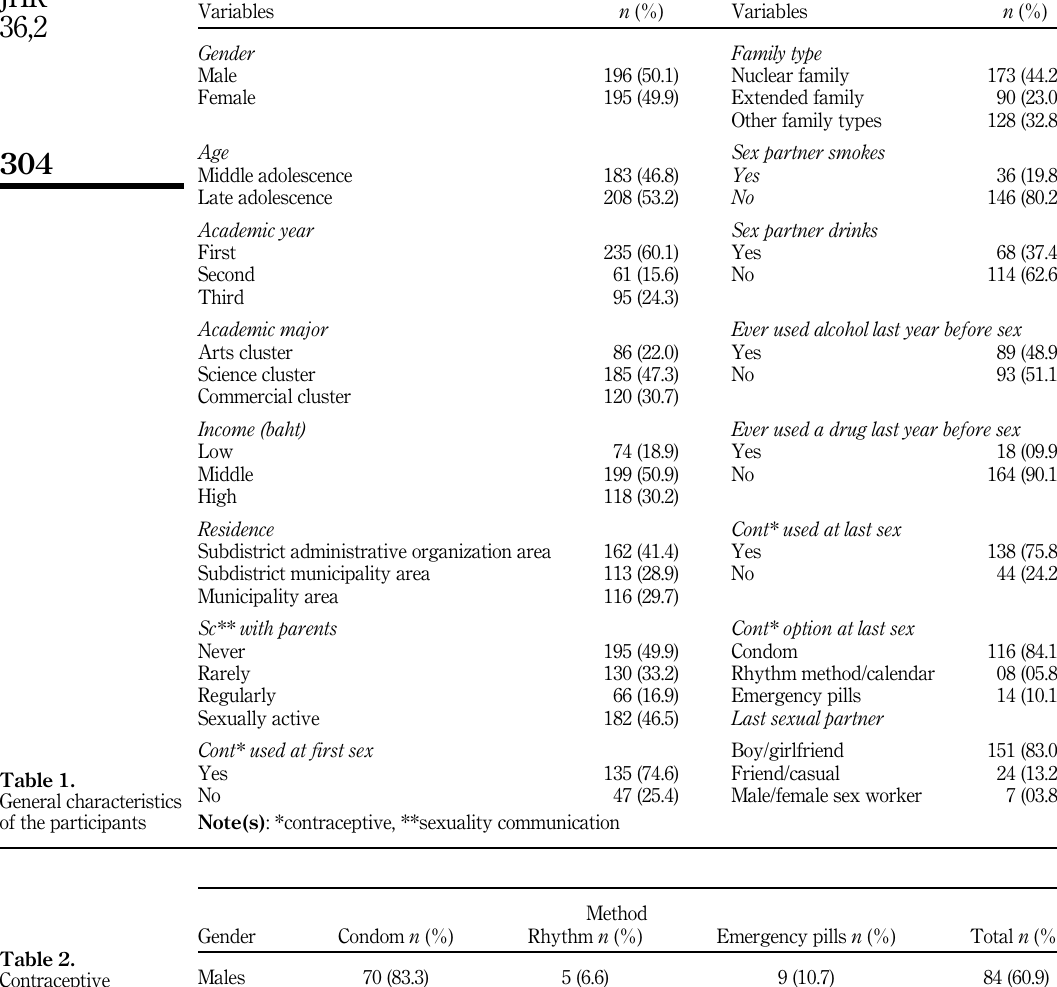
Table 2. Contraceptive preference by